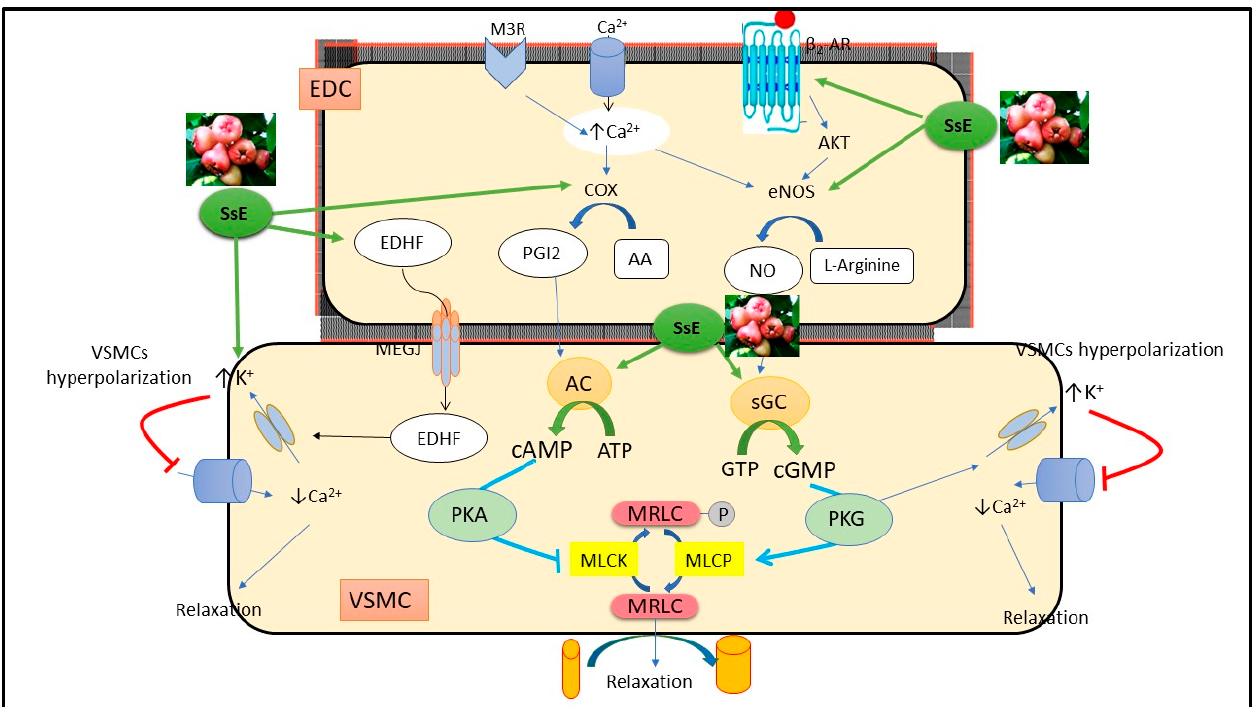
Figure 8. Mechanistic insight of S. samarangense extract on vascular reactivity of isolated aorta of rats. Abbreviations : AA; arachidonic acid; AC, adenylate cyclase; AKT, Protein kinase B; ATP, Adenosine triphosphate; β 2-AR, β 2 adrenoceptor; Ca 2+ , calcium; cAMP, cyclic adenosine monophosphate; c-GMP, cyclic guanosine monophosphate; COX; cyclooxygenase enzyme; EDC, endothelial cell; EDHF, endothelial dependent hyperpolarizing factor; eNOS, endothelial nitric oxide synthase; NO, nitric oxide; K + , potassium; PKA, protein kinase A; M3R, muscarinic 3 receptor; MEGJ, myoendothelial gap junction; MLCK, myosin light chain kinase; MLCP, myosin light chain phosphatase; MRLC, myosin regulatory light chain; P, phosphorous; PGI2, prostacyclin; VSMC, vascular smooth muscle cell; sGC, soluble guanylate cyclase; GTP, guanosine triphosphate; PKG, protein kinase G; SsE, S. samarangense extract. Adopted from Laban et al. [31].